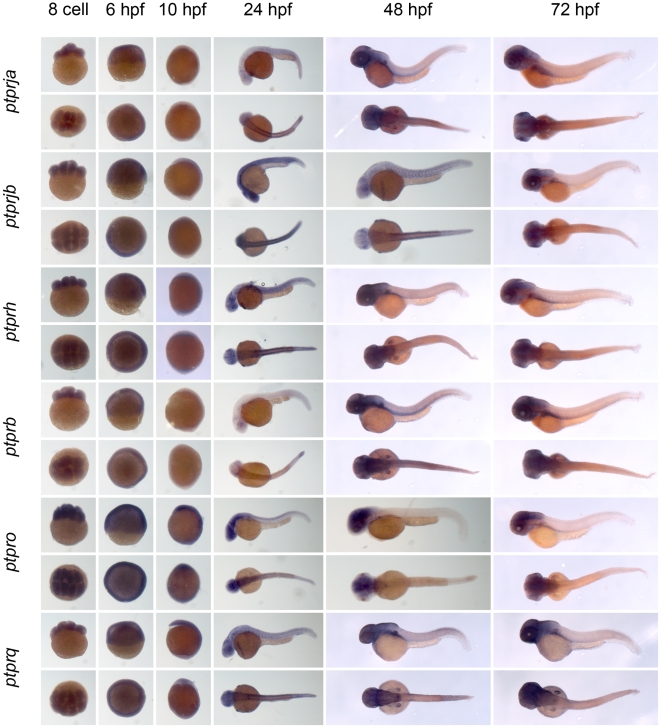
See legend to Fig. 3.